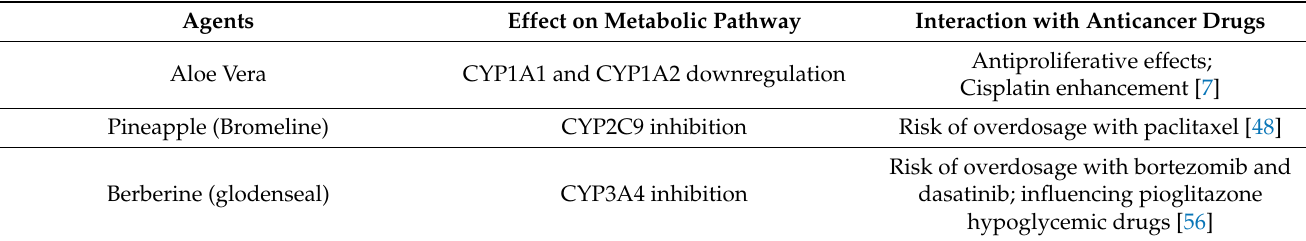
Table 4. Most common herbs/nutraceuticals used in cancer patients and their possible interactions with drugs.